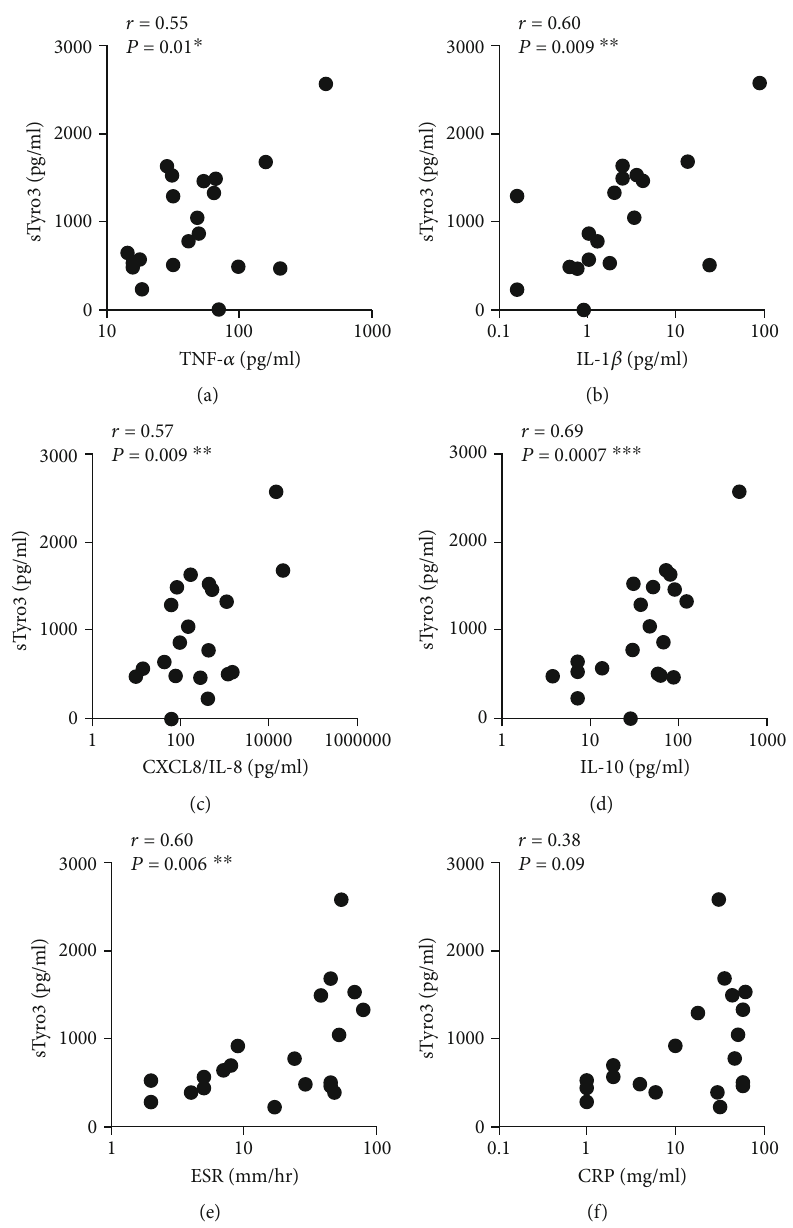
Figure 4: Relationship between soluble Tyro3 levels and in fl ammatory markers in the blood and synovial fl uid of RA patients. Relationship between soluble Tyro3 (sTyro3) and the cytokines TNF- α , IL-1 β , IL-8, and IL-10 in the synovial fl uid of rheumatoid arthritis patients ( n = 20 ). Correlations are depicted for sTyro3 – TNF- α (a), sTyro3 – IL-1 β (b), sTyro3 – IL-8 (c), and sTyro3 – IL-10 (d). Relationship between soluble Tyro3 (sTyro3) and erythrocyte sedimentation rate (ESR) and C-reactive protein (CRP) in the blood of rheumatoid arthritis patients ( n = 20 ). Correlations are depicted for sTyro3 – ESR (e) and sTyro3 – CRP (f). Data are presented as Pearson r value ( r ) and P value ( P ) for each correlation. ∗ P < 0 : 05 ; ∗∗ P < 0 : 01 ; and ∗∗∗ P < 0 : 001